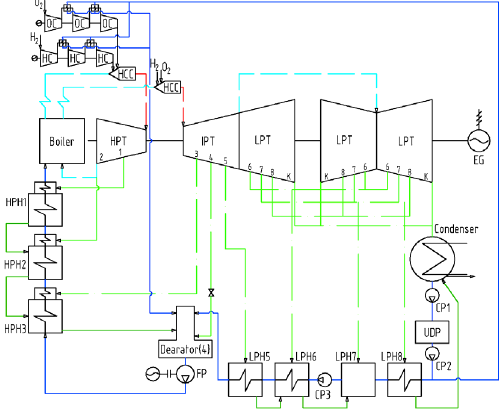
Figure 1. The heat flow diagram of a power unit heated with a HCC; HPT—high-pressure turbine; IPT—intermediate-pressure turbine; LPT—low-pressure turbine; HPH—high-pressure heater; LPH—low-pressure heater; FP—feed pump; OC—oxygen compressor; HC—hydrogen compressor; and EG—electric generator.